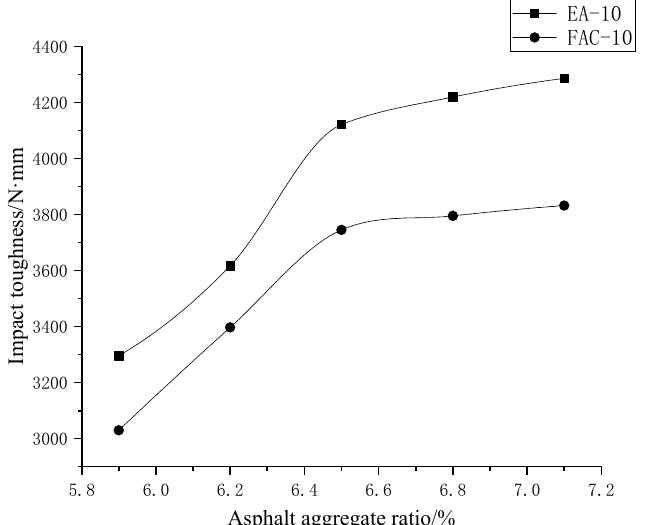
Figure 14. Relationship between different asphalt aggregate ratios and impact toughness.